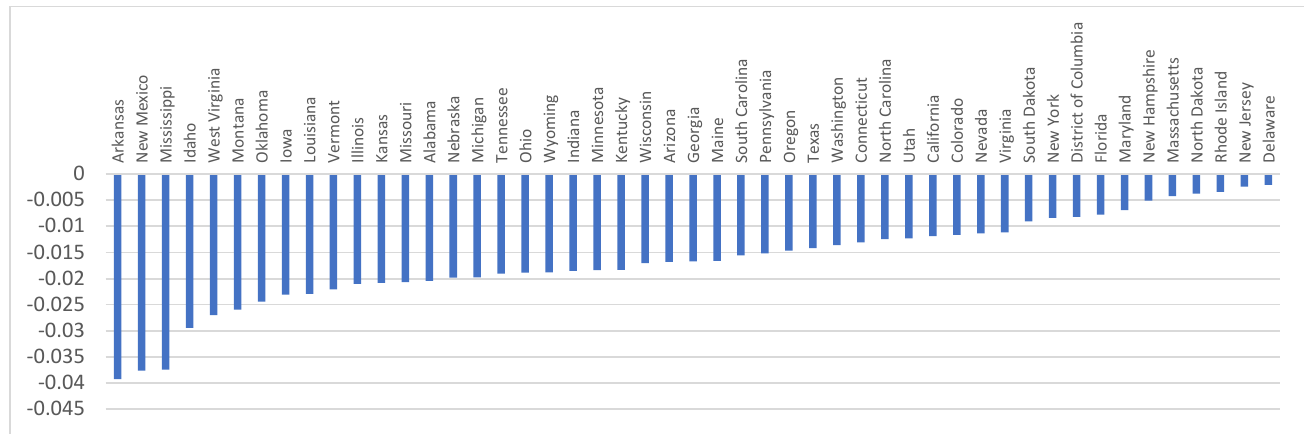
Figure 4. Elasticity GDP — Stringency Index.